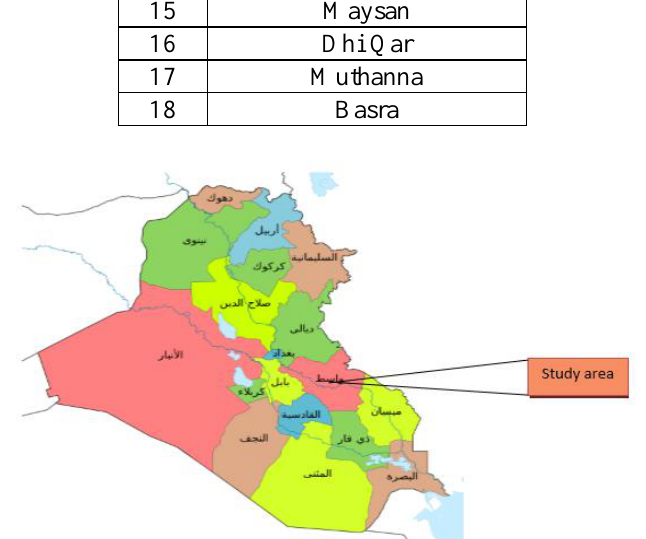
Fig. 1: The Kut city laying in Wast province in Iraq.